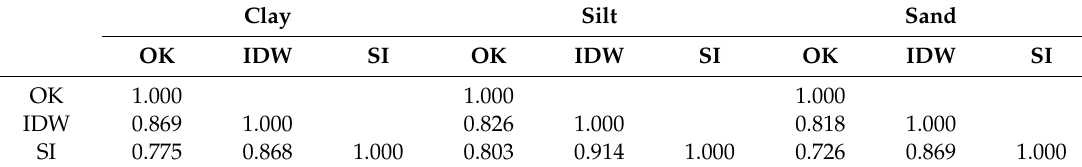
Table 5. Correlation matrix of interpolation results using Pearson’s coefficient of correlation.